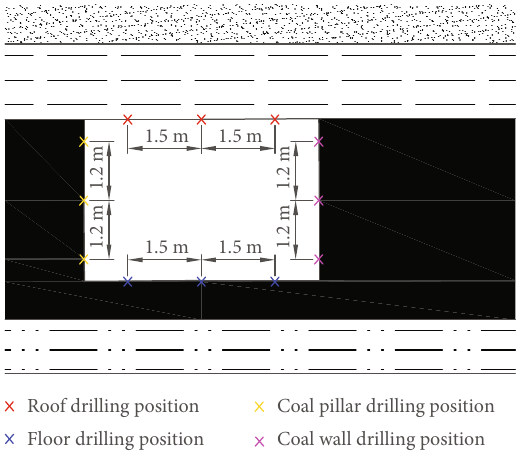
Figure 11: Borehole layout plan of transportation lane in 11030 working